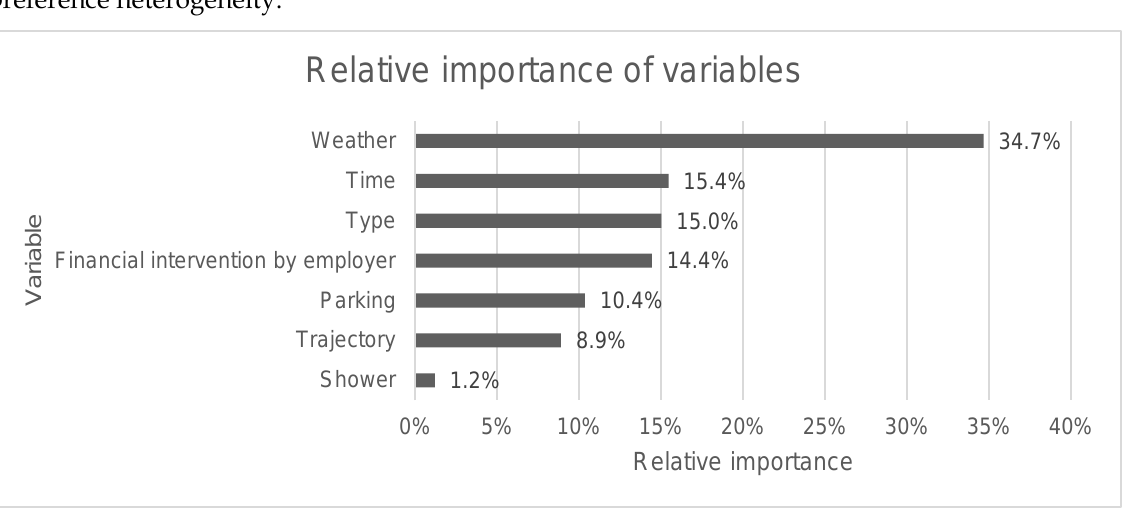
Figure 4. Importance of the Main Effects of the E-bike Journey